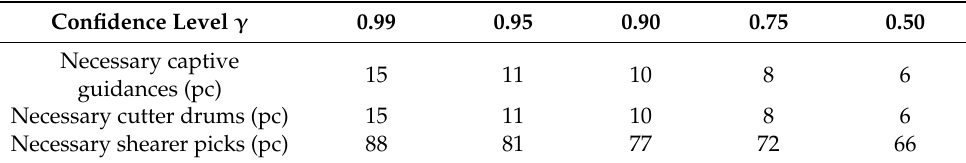
Confidence Level γ